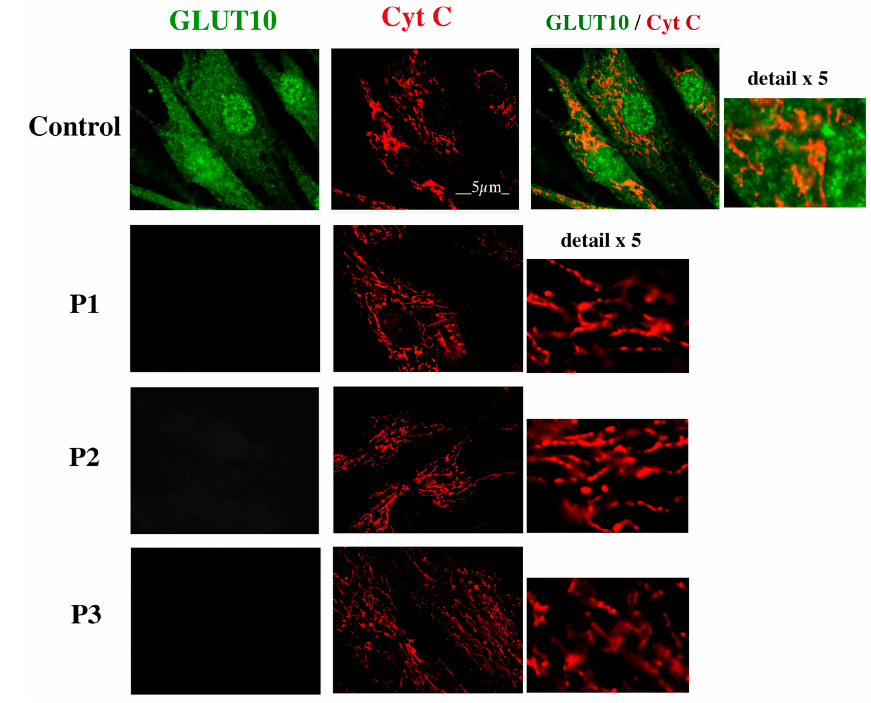
Figure 2. GLUT10 and mitochondrial immunostaining in fibroblasts from human healthy subjects and three arterial tortuosity syndrome (ATS) patients. Fibroblasts were prepared and immunoreacted with the anti-GLUT10 antibody Ab1 and an antibody to Cyt C, and the images were acquired by fluorescent microscopy as detailed in the “Experimental” section. P1, P2 and P3 indicate three unrelated ATS patients as described in the “Experimental” section. Scale bar = 5 µ m.